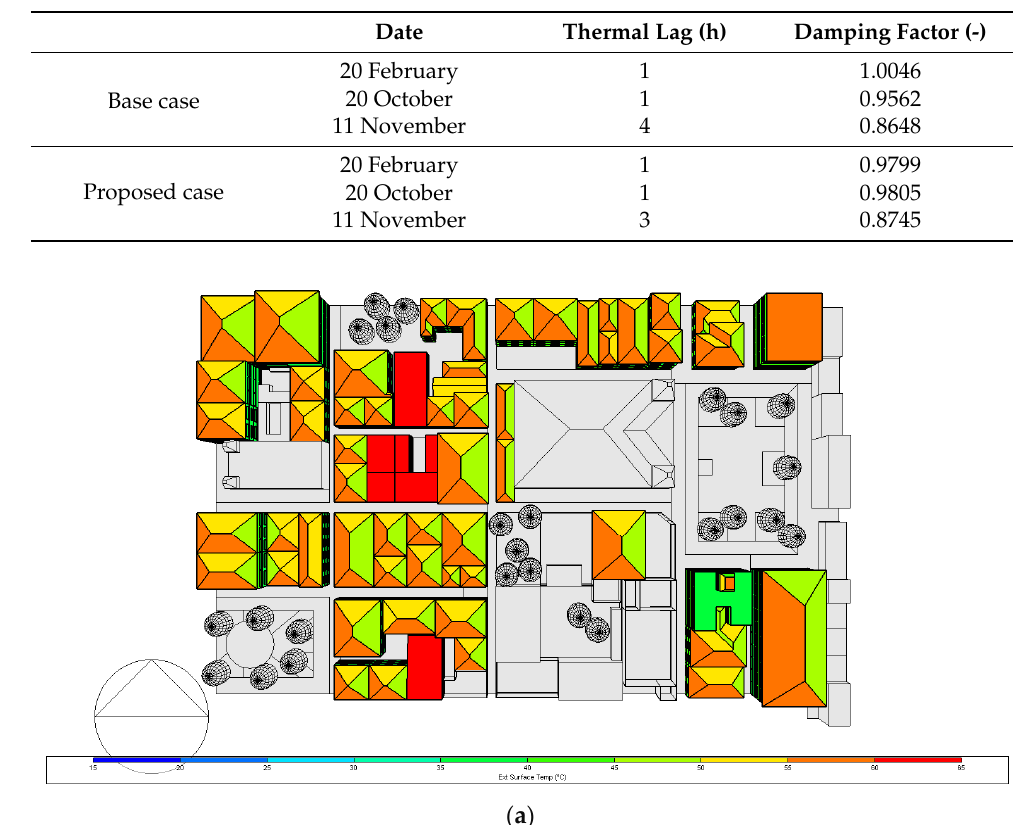
Table 7. Comparison of the thermal lag and damping factor, for both cases. Own elaboration.